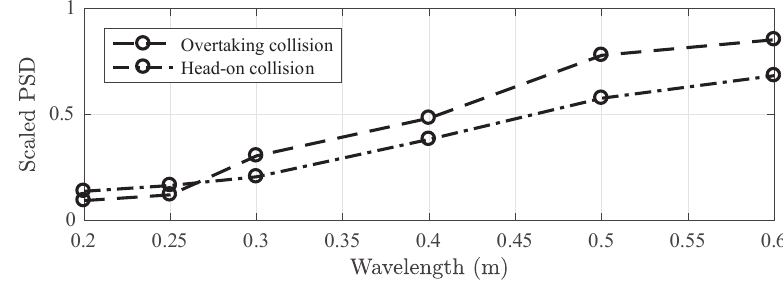
Figure 14. Maximum values of the scaled PSD observed in Fig. 13 vs. their corresponding